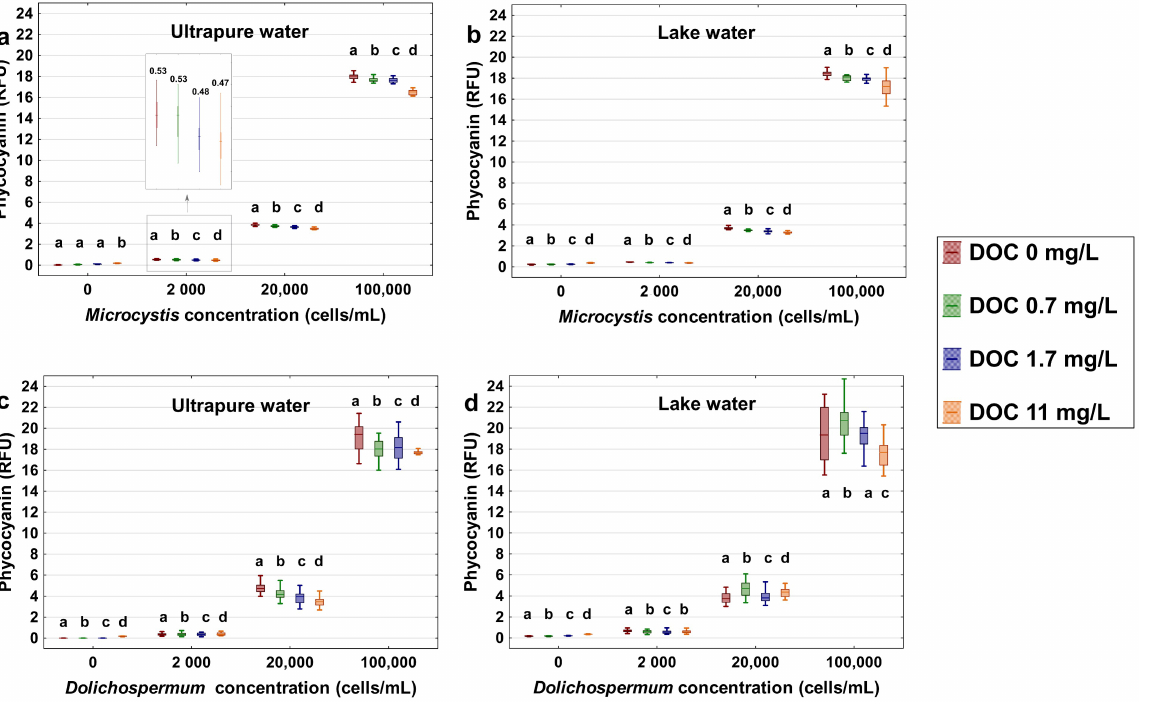
Figure 1. Phycocyanin readings (RFU) by using the YSI EXO2 probe of 0 (no cells added), 2000, 20,000, and 100,000 cells/mL of cyanobacterial species with spike 0, 0.7, 1.7, 11 mg/L dissolved organic carbon (DOC) of Suwannee River NOM (SRNOM): ( a , b ) Microcystis aeruginosa strain CPCC 300 suspended in 500 mL ultrapure water and Lake Champlain water; ( c , d ) Dolichospermum sp. strain CPCC 544 suspended in 500 mL ultrapure water and Lake Champlain water. The probe measured each of the sample at 250 ms interval for 10 min. The bottom and top of each box represent the 25th–75th percentiles, respectively. The whiskers represent the minimum and maximum values. The line within each box corresponds to the median value. Different letters represent significant differences between treatment comparisons (Kruskal–Wallis followed by Dunn’s post hoc test, p ≤